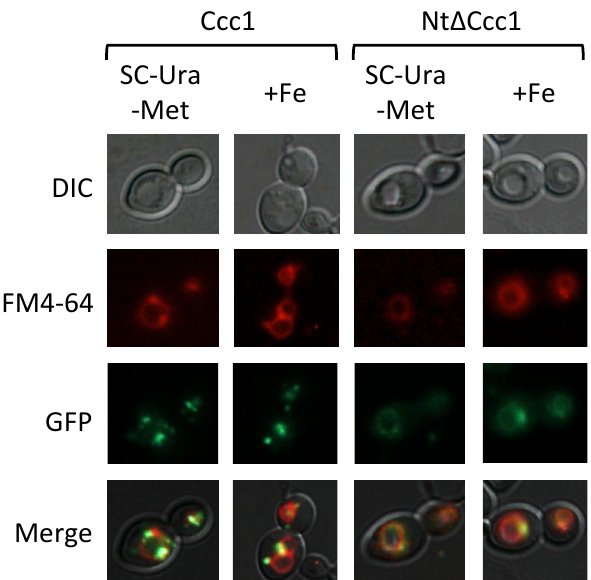
Figure 6. Subcellular localization of Ccc1 and Nt ∆ Ccc1 proteins in normal (SC-Ura-Met) and high- iron (+Fe) conditions. Yeast cells were cultivated as described in Figure 5, and visualized under Nomarski (DIC) and GFP fluorescence optics. Vacuolar membranes were stained with the styryl dye FM4-64 as indicated in Materials and Methods. Merge shows the overlap of the different